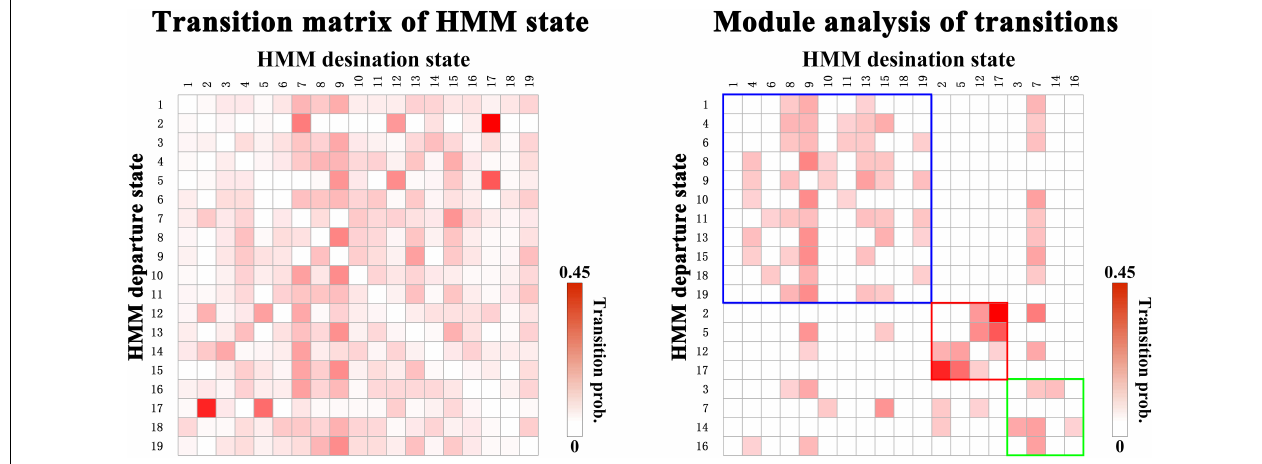
FIGURE 4 | The modules of transitions between HMM states.